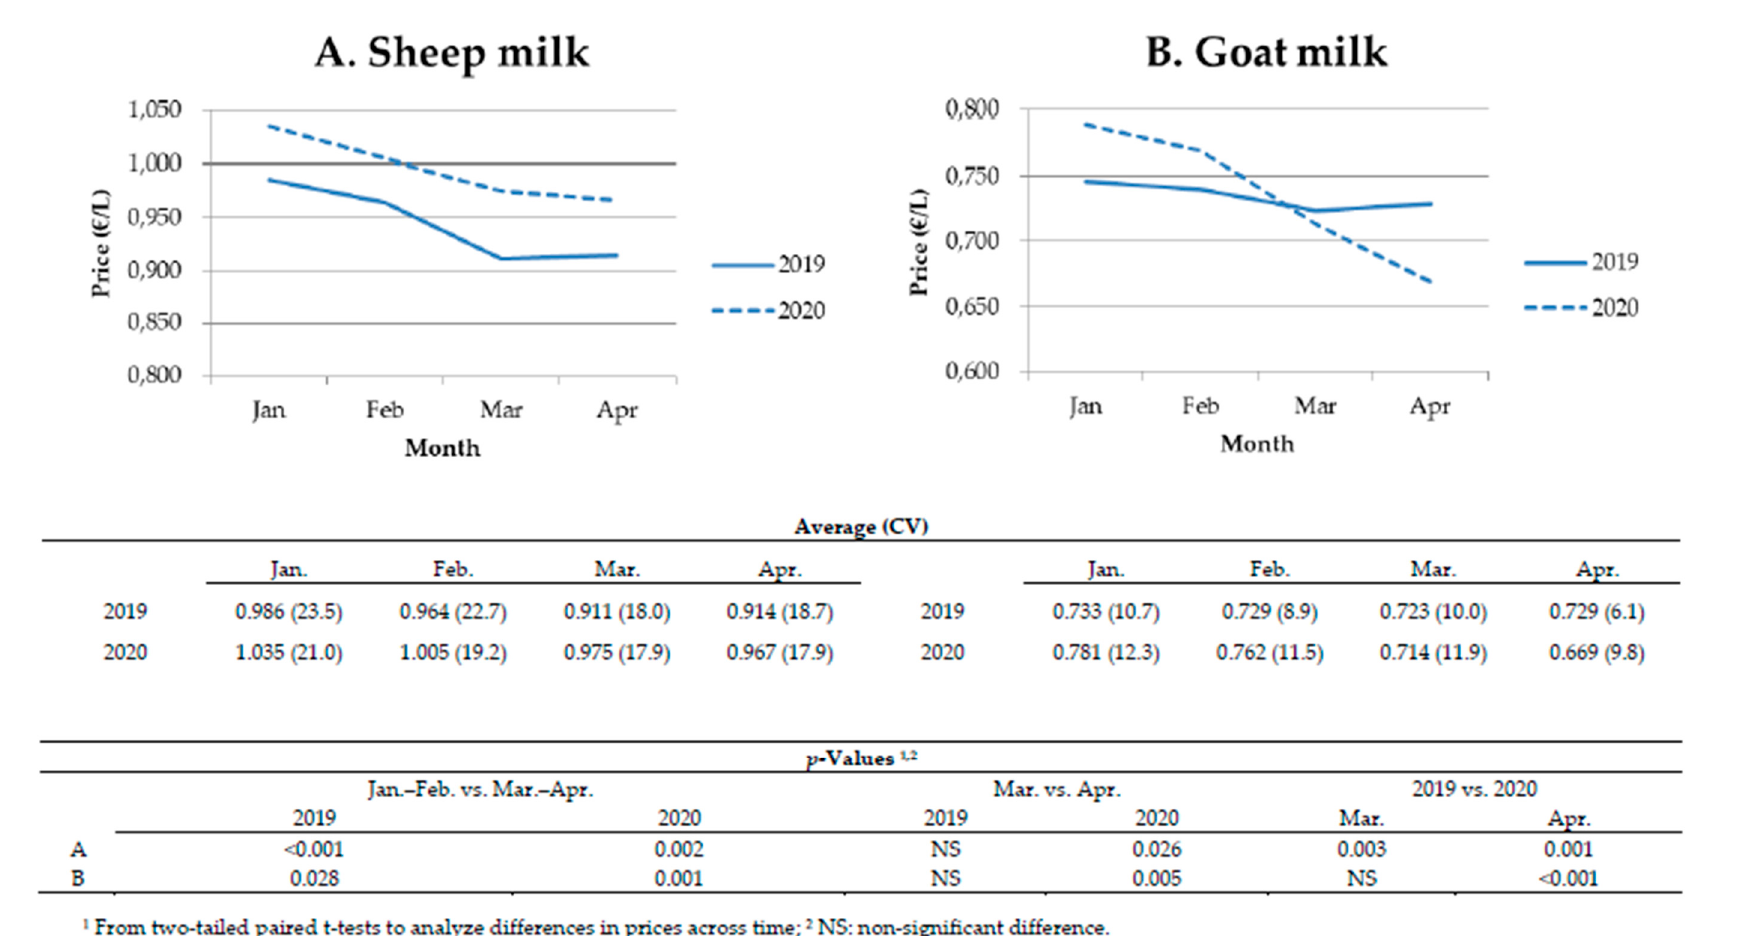
Figure 2. Average monthly price per liter (EUR/L) of sheep ( A ) and goat milk ( B ) reported by producers from January to April 2019 and 2020 (coefficient of variation, %), with intra- and interannual comparisons. Data from 23 and 22 dairy sheep and goat flocks, respectively.